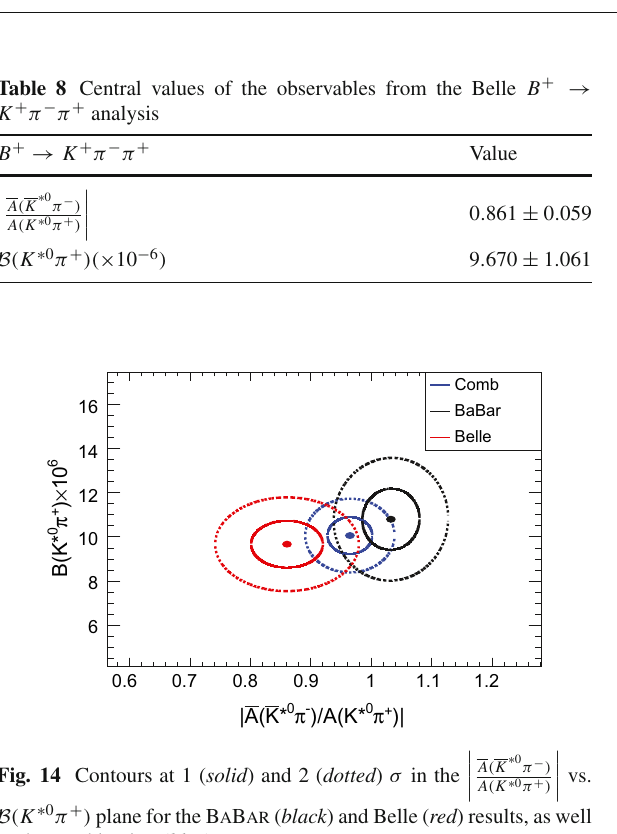
Table 7 Central values and total (statistical and systematic) correlation matrix for the global (top) and local solution (bottom, (cid:9) NLL = 7 . 5) minimum solutions of the observables from the Belle B 0 → K 0